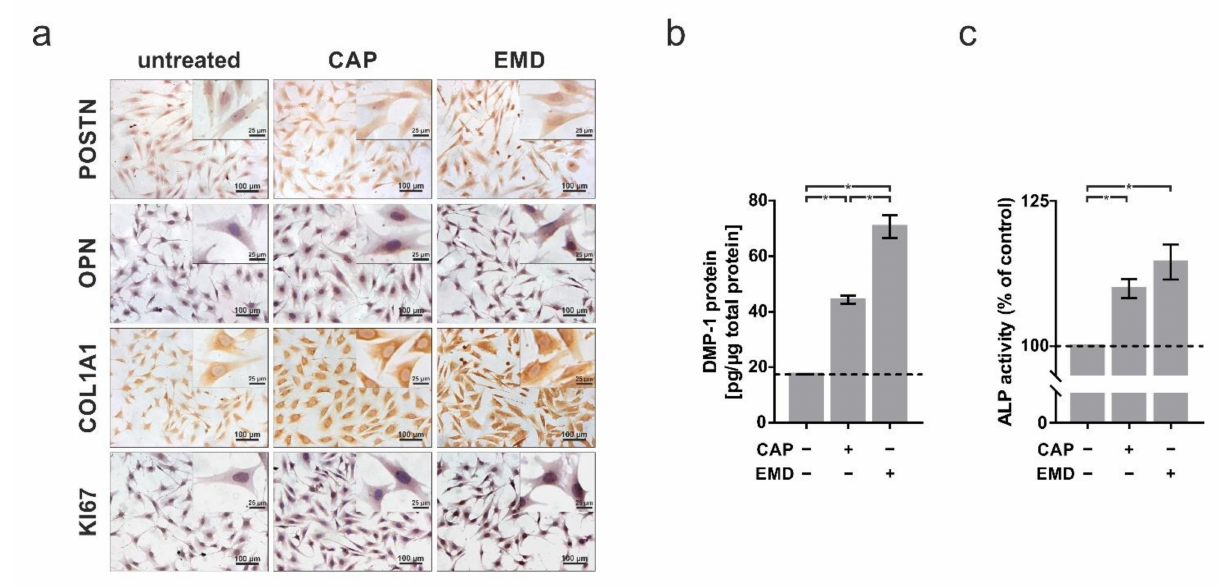
Figure 2. Protein regulation of selected markers in OCCM-30 cells after 60 s of CAP and 100 µ g/mL of EMD treatment, respectively (+) as compared to untreated cells ( − ). ( a ) Immunocytochemistry staining of POSTN, OPN, COL1A1, and KI67 at two days. The scale bars represent 100 µ m and 25 µ m, respectively. ( b ) Protein expression of DMP1 normalized to total protein at two days ( n = 9). ( c ) ALP activity at two days ALP activity in OCCM-30 cells after 60 s of CAP and 10 µ g/mL of EMD at two days ( n = 9). * statistical significance ( p < 0.05).